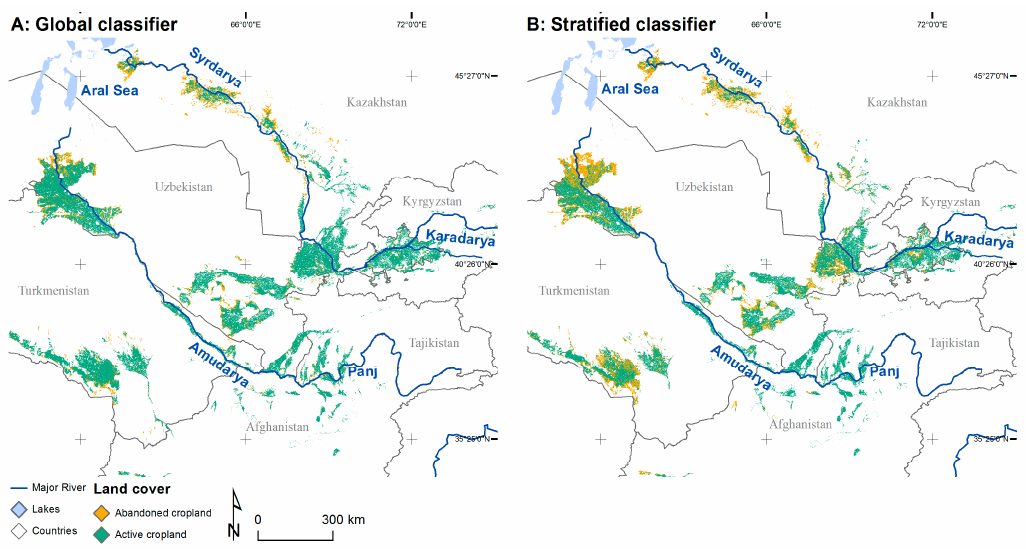
Figure 6. Comparison of the map of abandoned irrigated cropland for the global (left) and stratified (right) classifier method. Table 3. Comparison of the area under receiver operator curves and the overall, user’s and producer’s accuracies. Lower (LI) and upper (UI) values indicate the 95% confidence intervals (CI) of the overall accuracy.